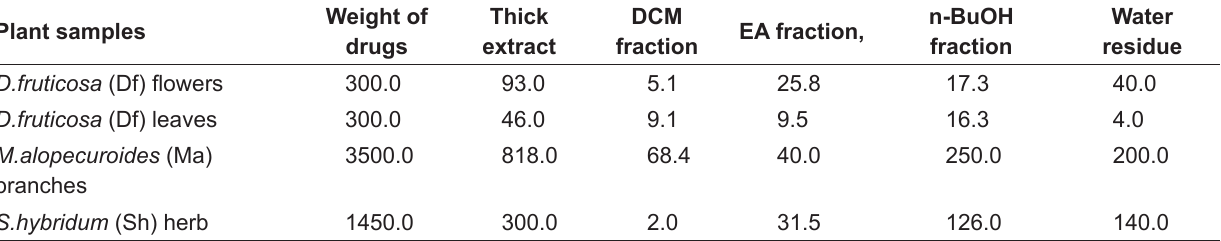
Table 1. Yield of extracts and fractions,